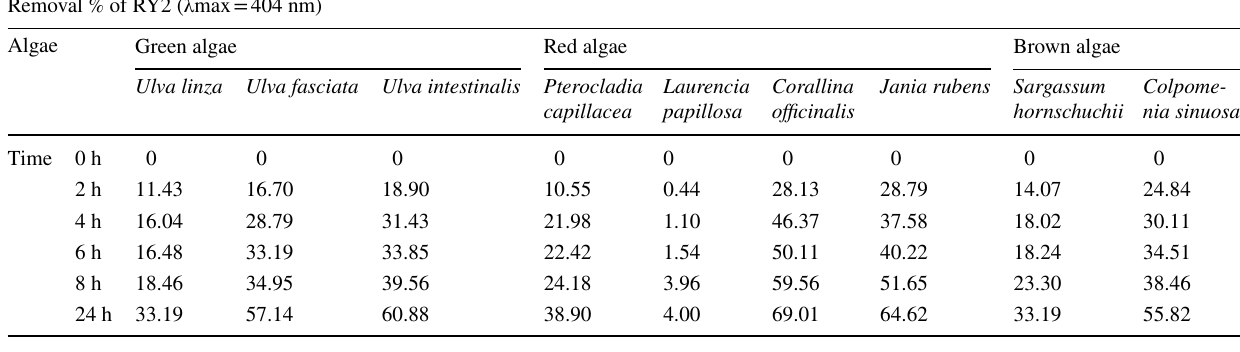
Fig. 3 Removal percentage of Reactive Yellow 2 by the nine studied fresh algal